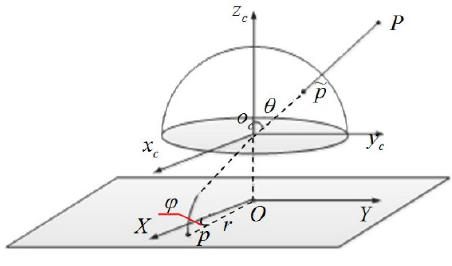
Figure 1. Projection of a point.